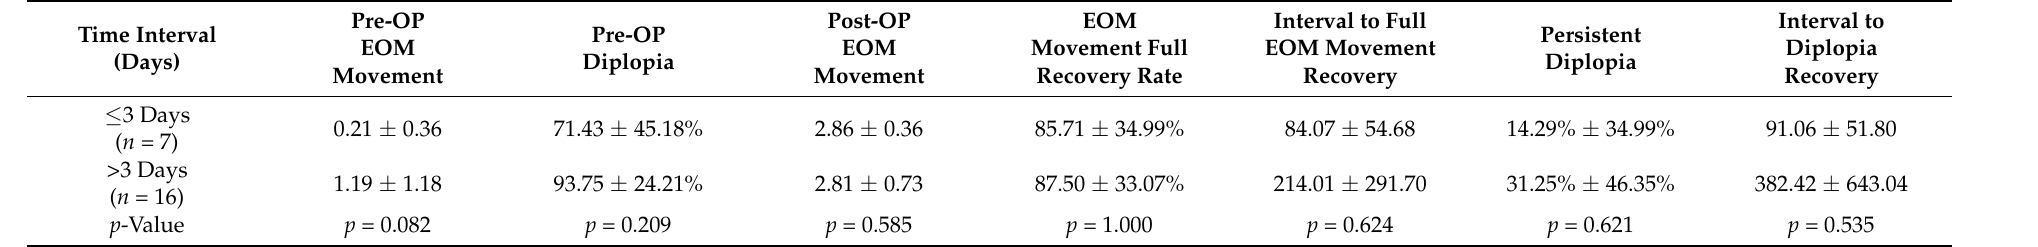
Table 3. Comparison of functional outcome by time interval to surgical intervention.